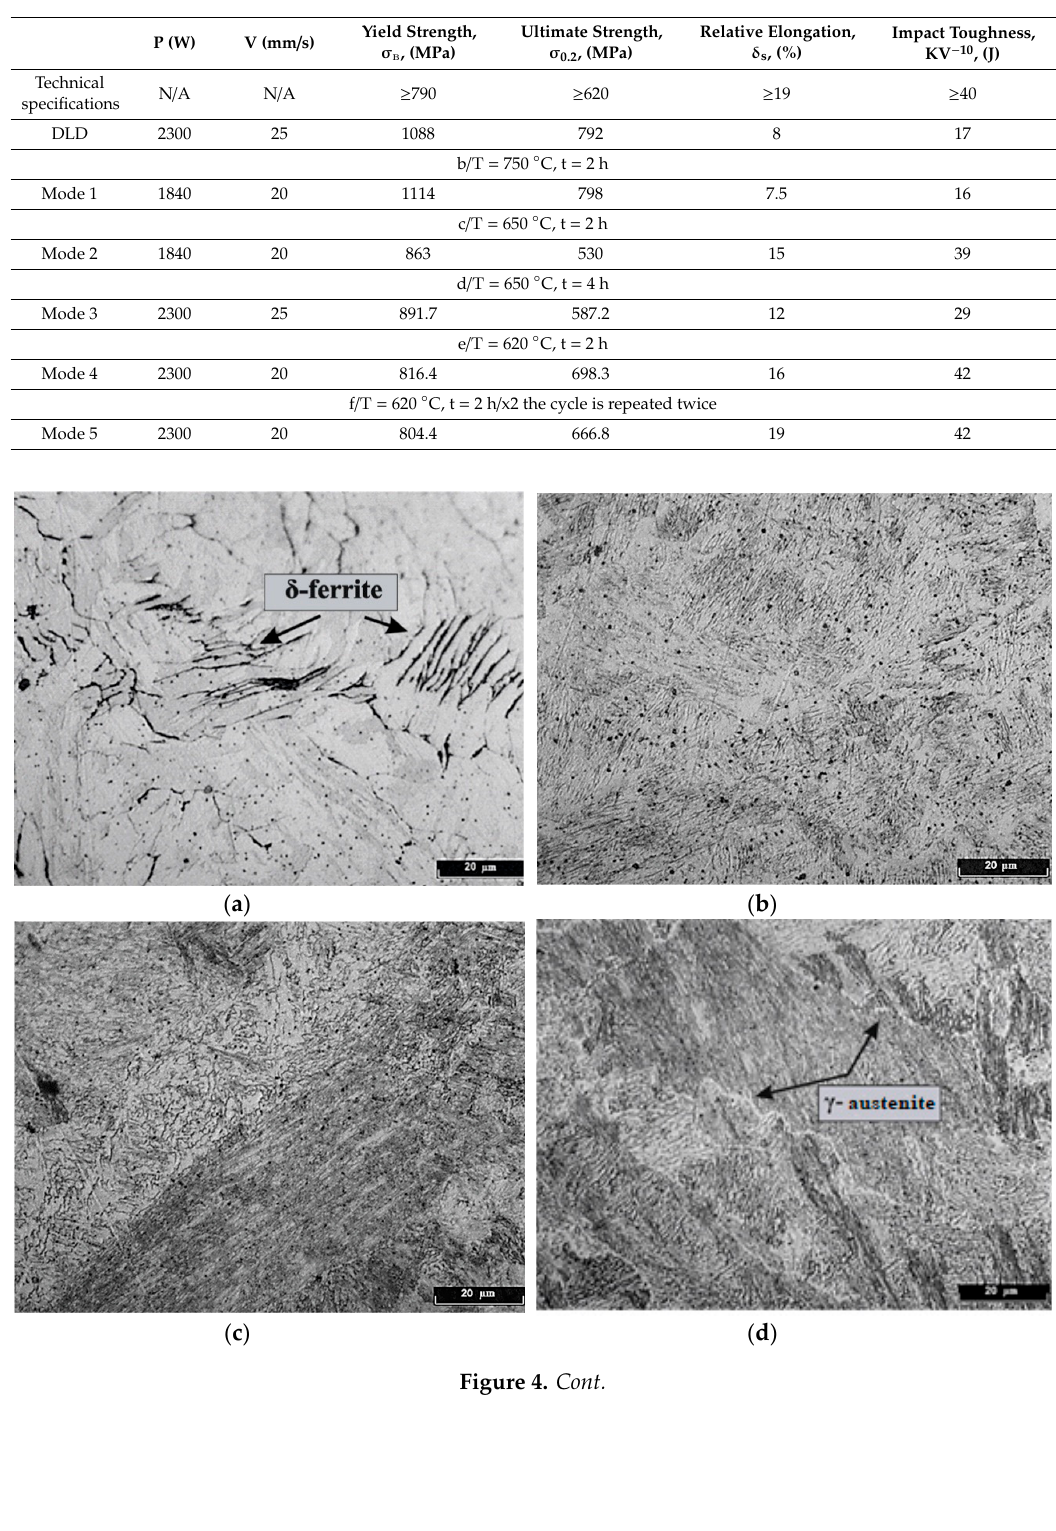
Table 2. Mechanical properties for heat treatment (HT) modes.